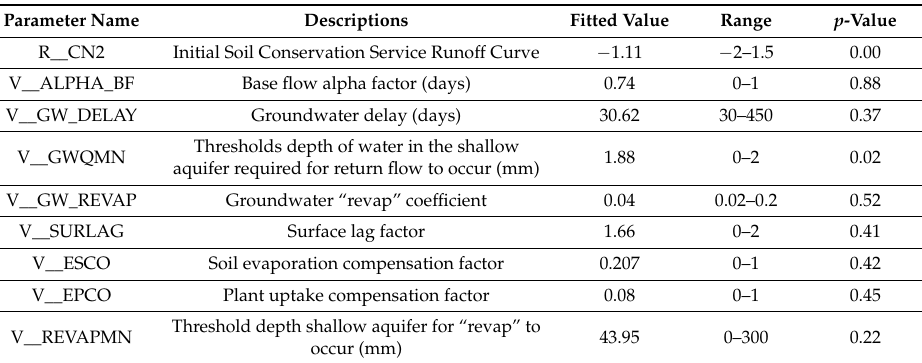
Table 2. Sensitivity analysis for the SWAT model without OWTS.